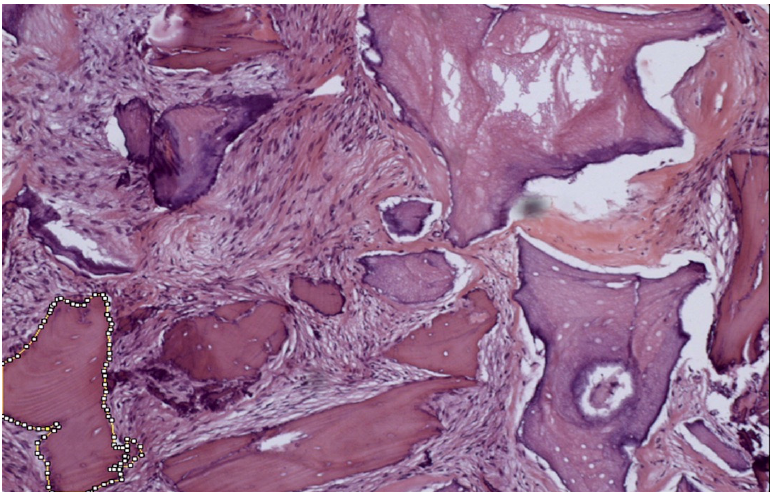
Figure 2. Histological section photography evaluated in ImageJ software.